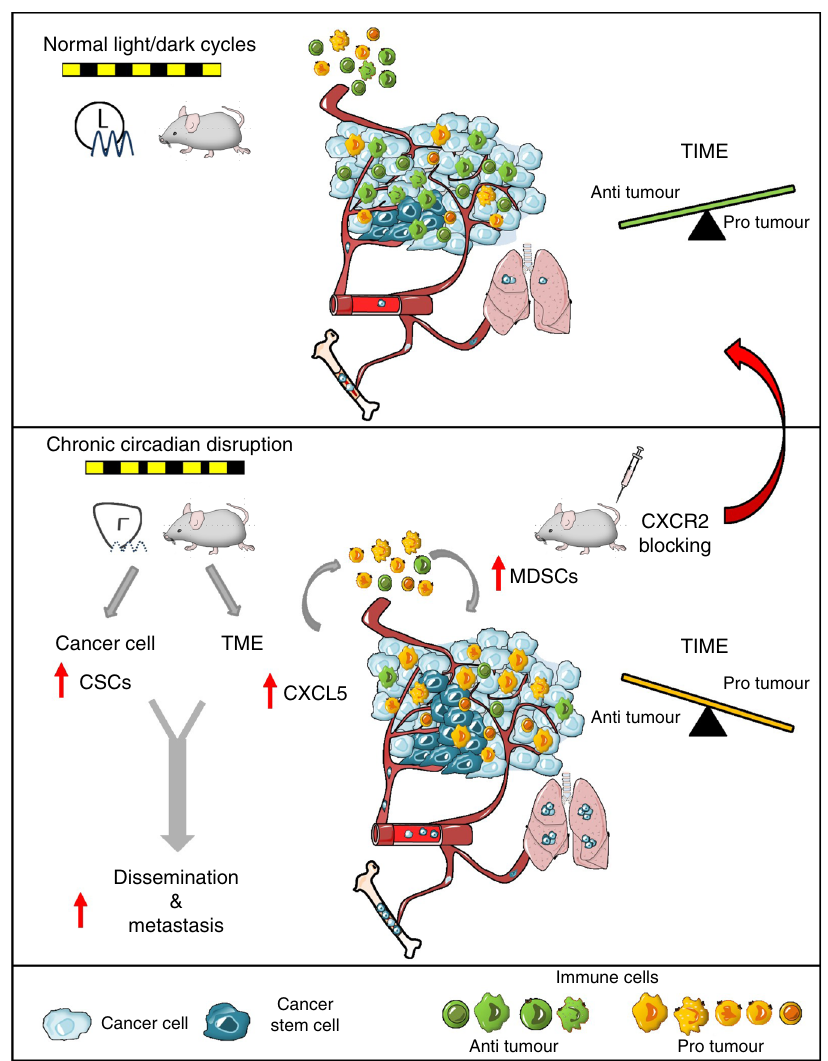
Fig. 7 Conceptual schema. Chronic circadian disruption (CRD) alters two key aspects of tumour biology. It increases the proportion of cancer stem cells (CSCs, in dark blue) and modi fi es the tumour microenvironment (TME) through the recruitment of myeloid-derived suppressor cells (MDSCs, in yellow), resulting in a suppressive tumour immune microenvironment (TIME). At least one mechanism that could drive this process is an enhanced CXCL5-CXCR2 axis in the TIME. Collectively, these effects result in increased dissemination and metastasis in bone marrow and lungs. Inhibition of the CXCR2 axis is able to alleviate the effect of CRD and recover anti-tumour